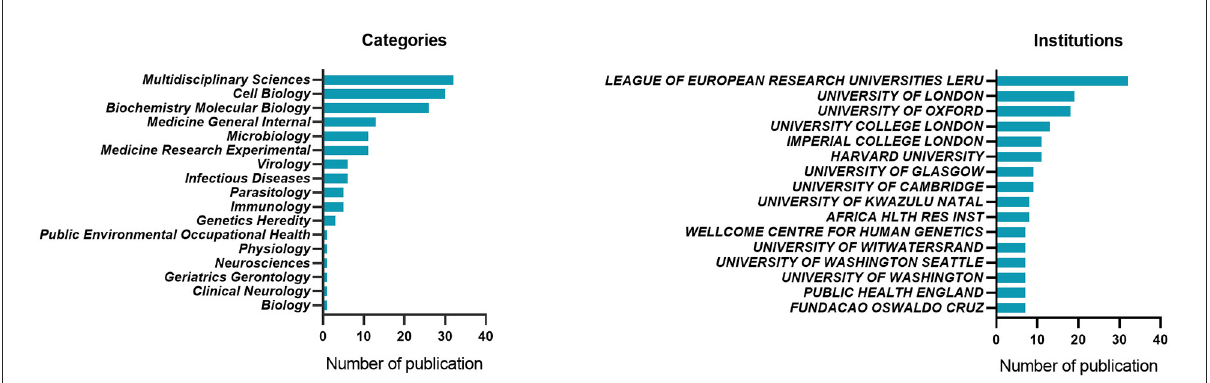
FIGURE3 Top 15 institutions and study categories of the total number of